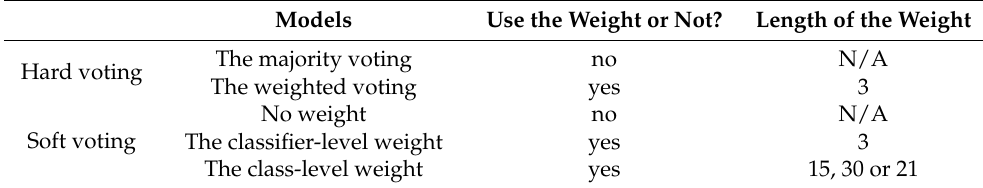
Table 4. The weight comparison of different voting ensemble